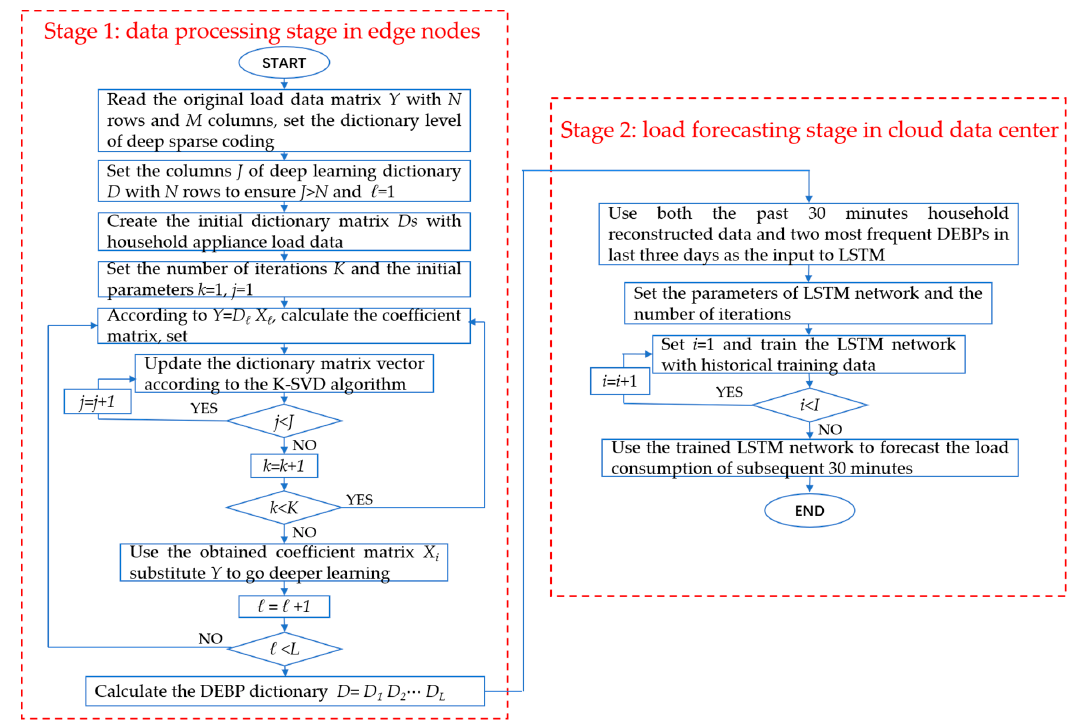
Figure 6. Flowchart of proposed two-stage household electricity demand estimation approach.